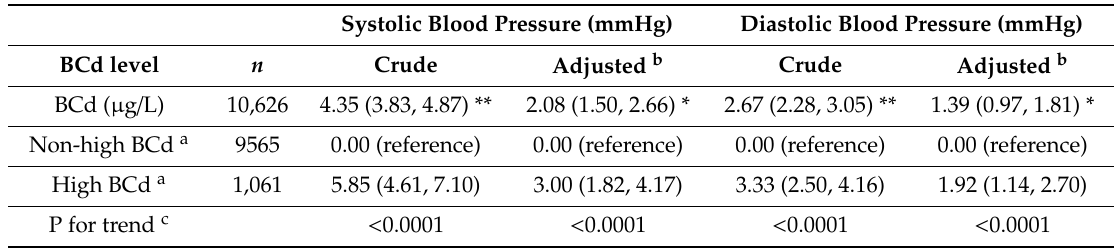
Table 4. Change (95% CIs) of systolic and diastolic blood pressure levels according to BCd level ( µ g / L). Systolic Blood Pressure